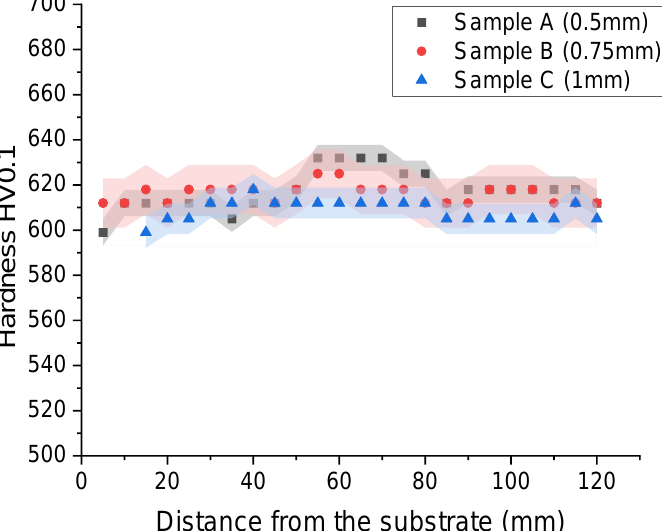
Figure 8. Graph of the microhardness distribution along samples. Table 6. Strength properties. Measurement uncertainty presented as 2